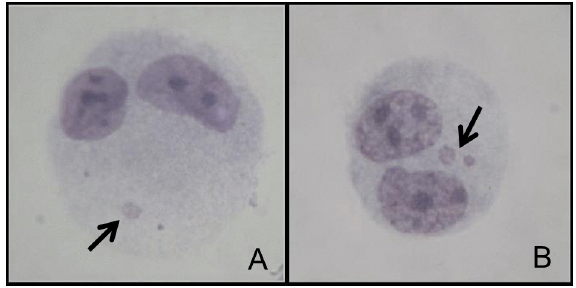
Figure 1. HTC binucleated cells with micronuclei (arrow) (A and